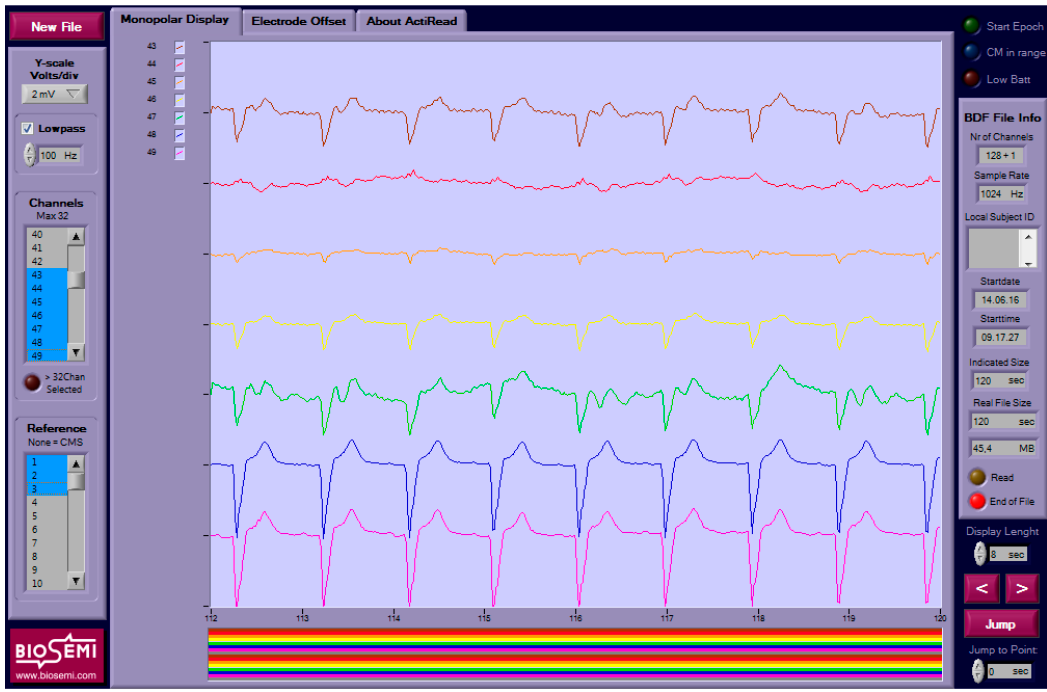
Figure 2. Example of raw signals. Signals are recorded from strip 7, electrodes 43–49 (see Figure 1a). The first three signals are utilized as Wilson’s central terminal (WCT) reference for others. The sampling frequency is 1024 Hz (see on right in the second box from